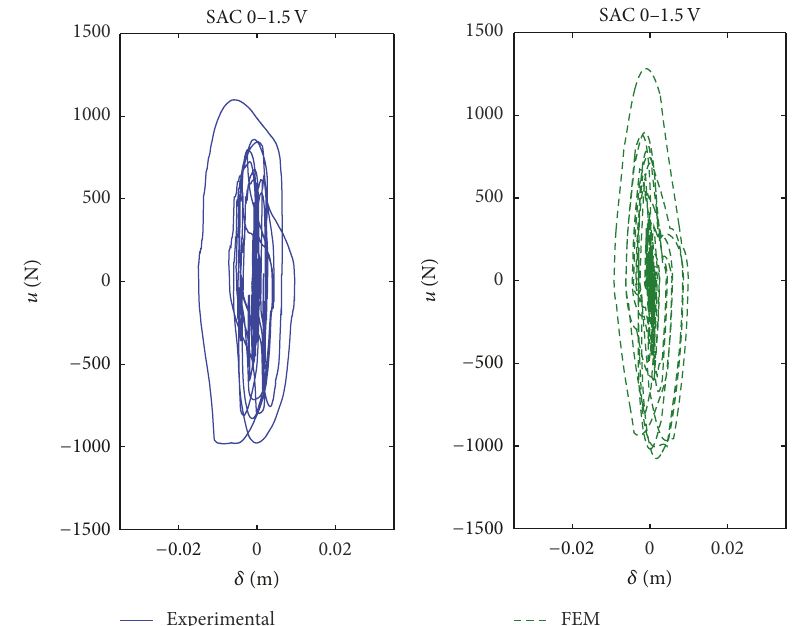
Figure 15: Semiactive connected (SAC) configuration, 0–1.5V, experimental versus FEM force-displacement loop. Kobe test PGA 0.5